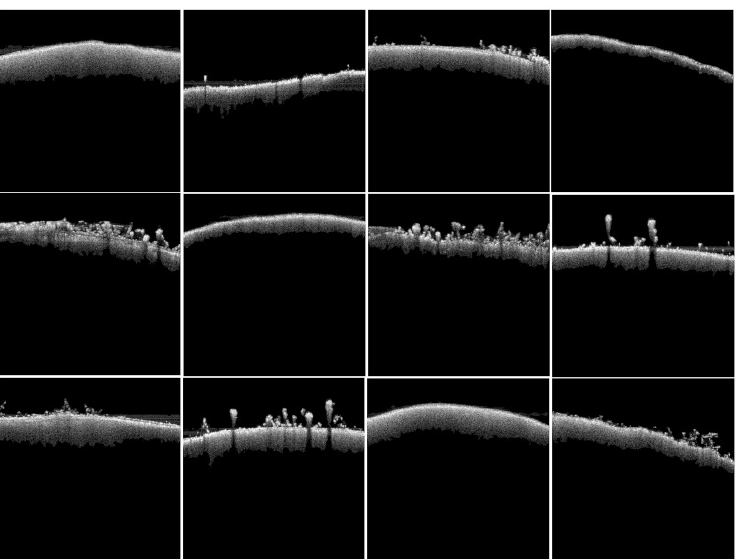
Figure 6. Exemplar segmented OCT images after combining the binary masks and the respective input